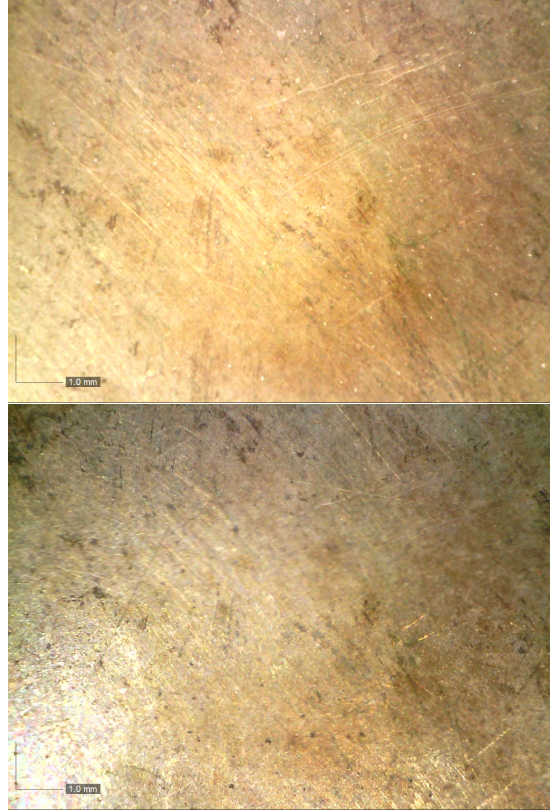
Figure 4. Microphotos of Tumbaga samples (30 × magnification).